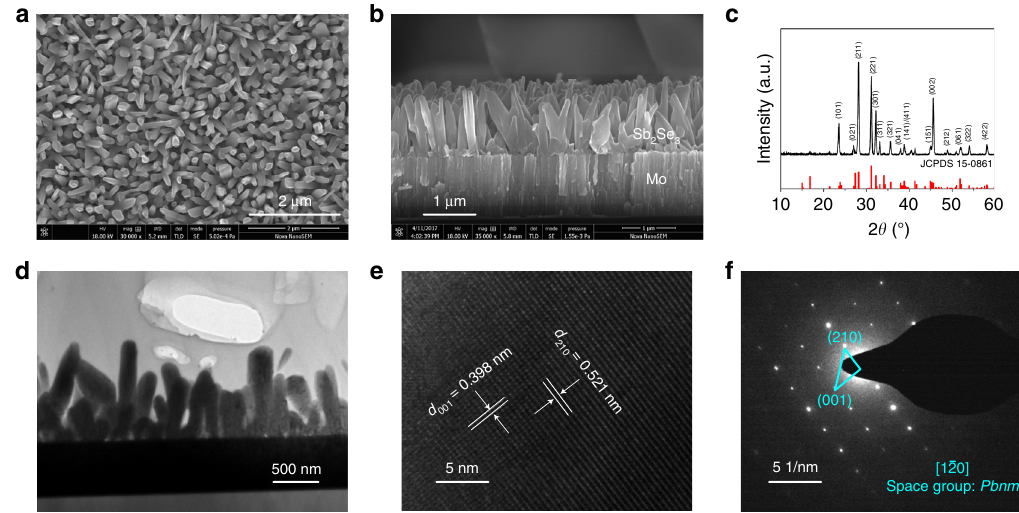
Fig. 1 Microscopy and spectroscopy of Sb 2 Se 3 nanorod array. a – c Top-view ( a ), cross-sectional ( b ), SEM images and X-ray diffraction pattern ( c ) of the Sb 2 Se 3 nanorod arrays grown on Mo-coated glass substrate. d – f TEM image ( d ), high resolution TEM (HRTEM) image ( e ), and the corresponding selected-area electron diffraction (SAED) pattern ( f ) of the Sb 2 Se 3 nanorod